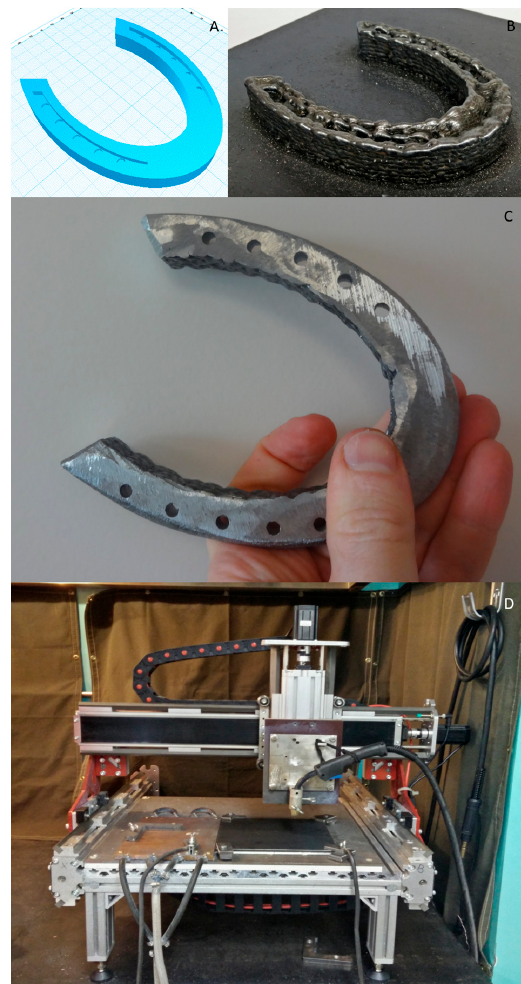
Figure 4. A horseshoe and CNC Router Parts 3-D printer conversion ( A ) 3-D model; ( B ) metal 3-D printed part on substrate; ( C ) finished part; and ( D ) a converted CNC Router Parts metal 3-D printer.